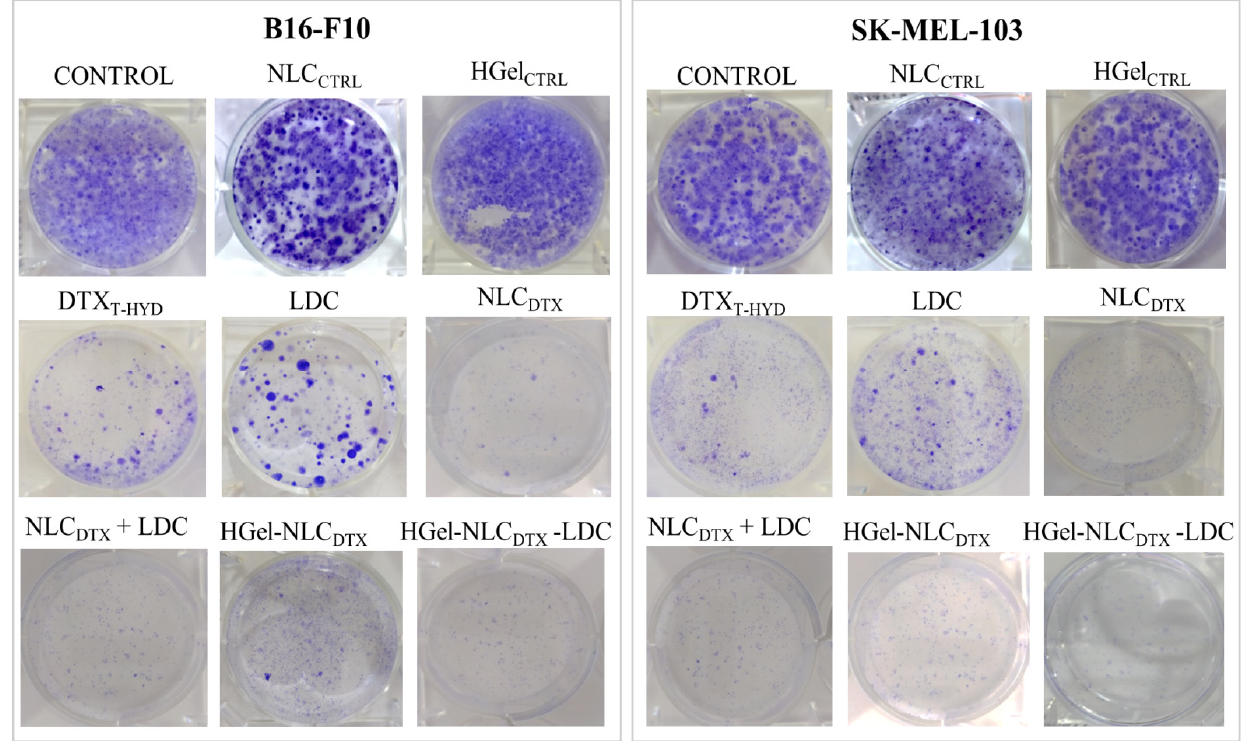
Figure 3. Clonogenic assay. Effect of the treatment with formulations on the ability of cancer (B16-F10) and SK-MEL-103) cells to form colonies.